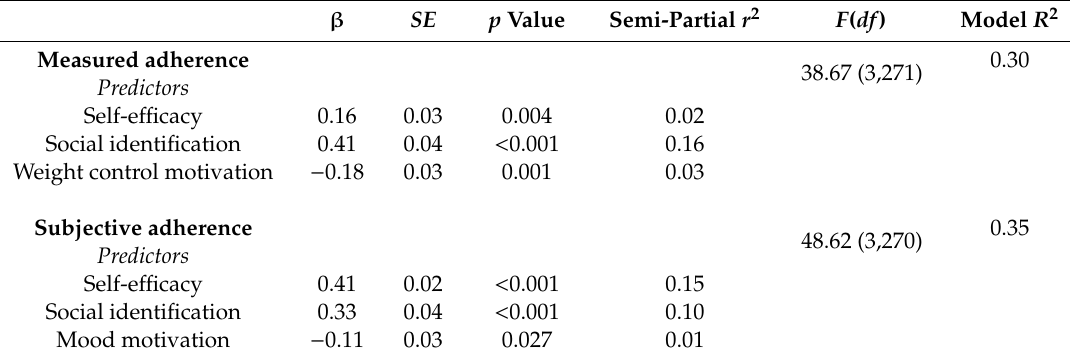
Table 2. Final regression models predicting dietary adherence (one regression analysis for each dependent